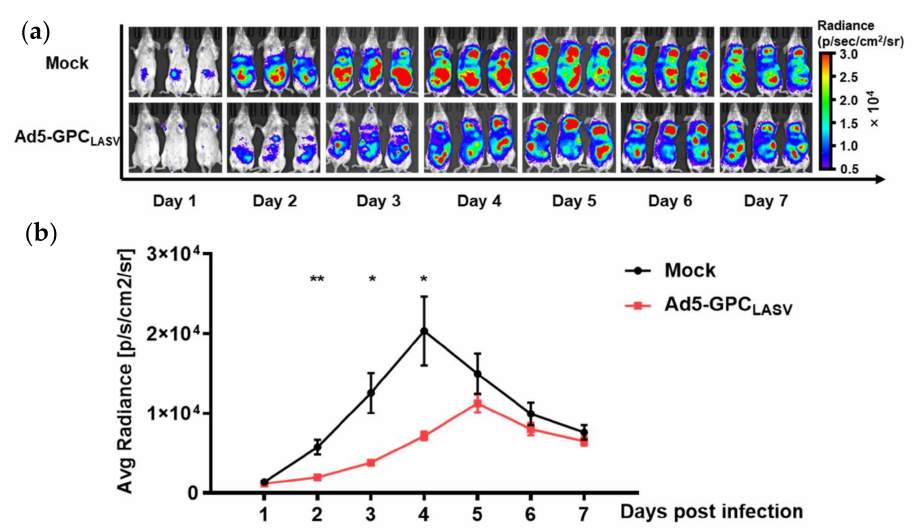
Figure 7. Ad5-GPC LASV provided protection against LASV pseudovirus infection in mice. BALB/c mice ( n = 3 per group) were intramuscularly (i.m.) inoculated with a single dose of 10 7 PFU of Ad5-GPC LASV , followed by intraperitoneal (i.p.) inoculation with 10 5 TCID 50 LASV pseudovirus after 28 days. Bioluminescent images were acquired 1 day later ( a ). Values for average radiance at different time points are shown ( b ). Data are presented as mean ± SEM, and statistical significant differences (Student’s t -test) are marked by bars and asterisks (* p < 0.05; ** p <